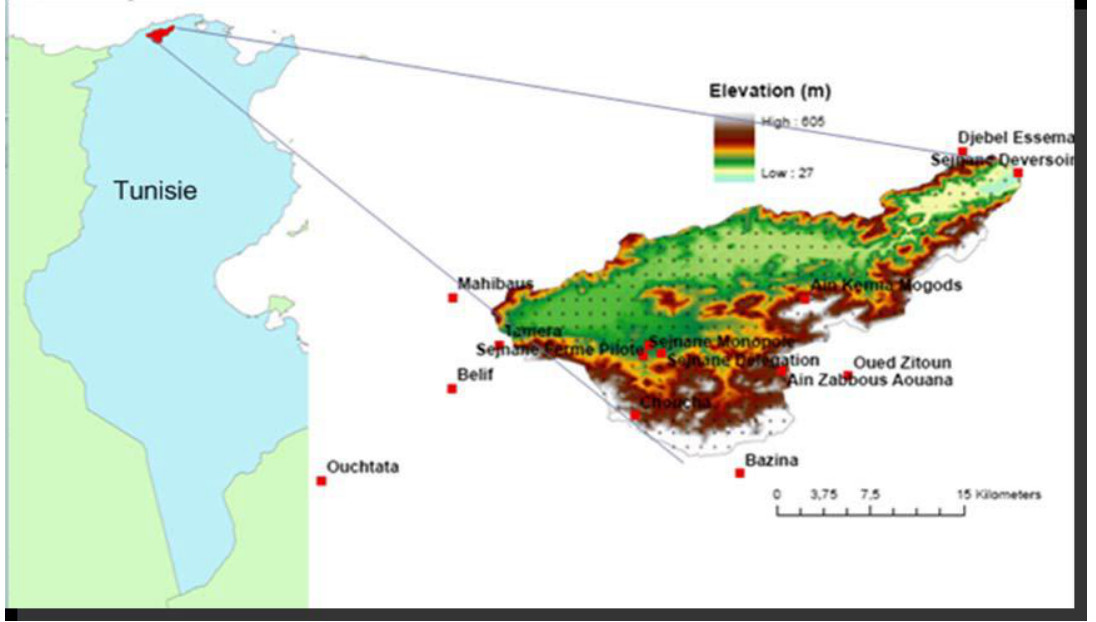
Figure 1. Localization of the study area with rainfall stations